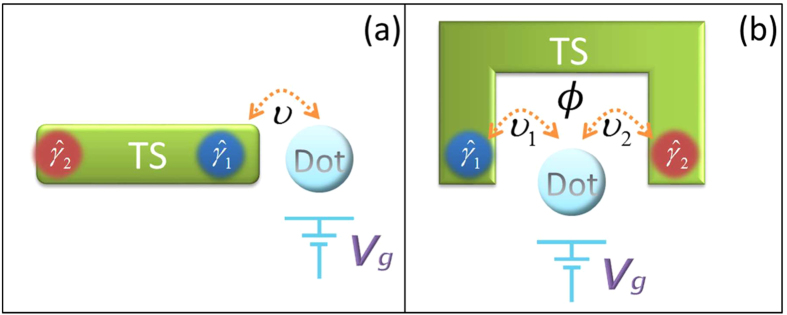
The schematic setup for realizing the operation P1.